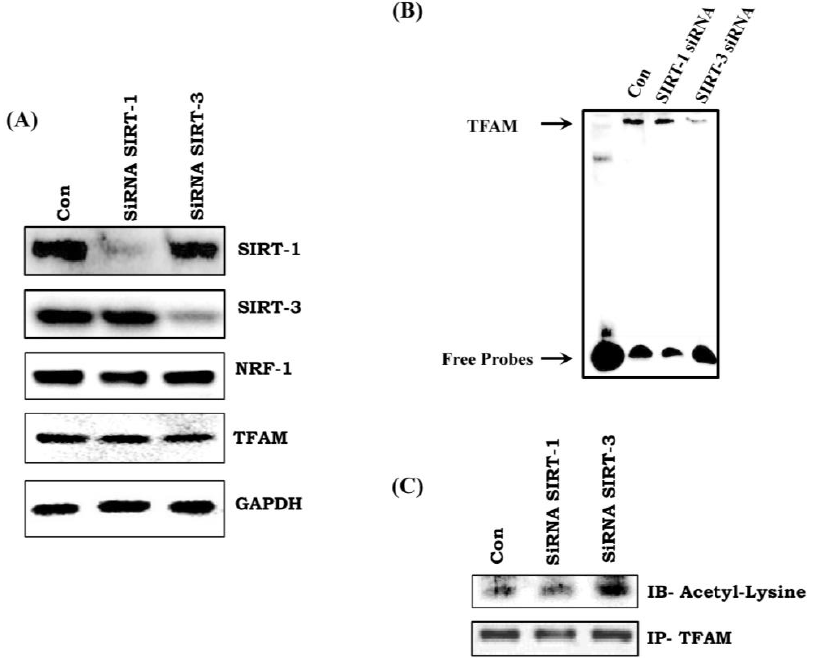
Figure 6. SIRT-3 specifically regulates the acetylation status of TFAM. ( A ) Effect of SIRT-1 and SIRT-3 silencing on TFAM and NRF-1 expression; ( B ) TFAM activity as measured by EMSA assay in SIRT-1 and SIRT-3 silenced cells; ( C ) Acetylation status of TFAM in SIRT-1 and SIRT-3 silenced cells. Data shown as representative of three different